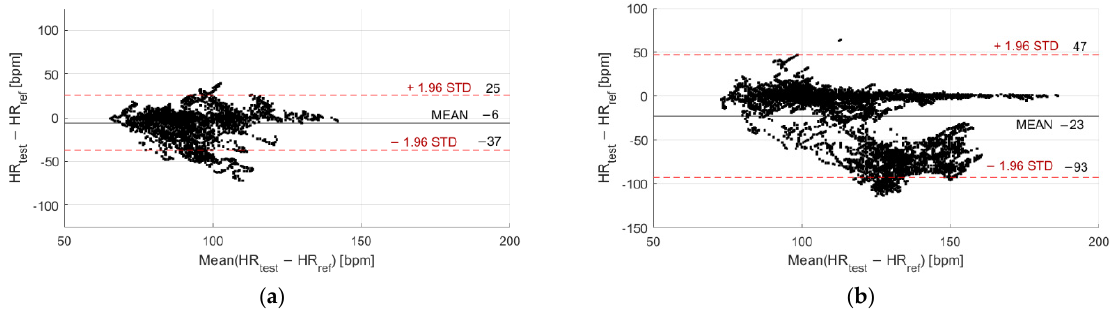
Figure 11. Bland–Altman plot related to recordings performed ( a ) Resting and ( b ) During activities, including recordings both at in-water and dry conditions performed with Garmin Venu Sq (reference instrument: Polar H10).